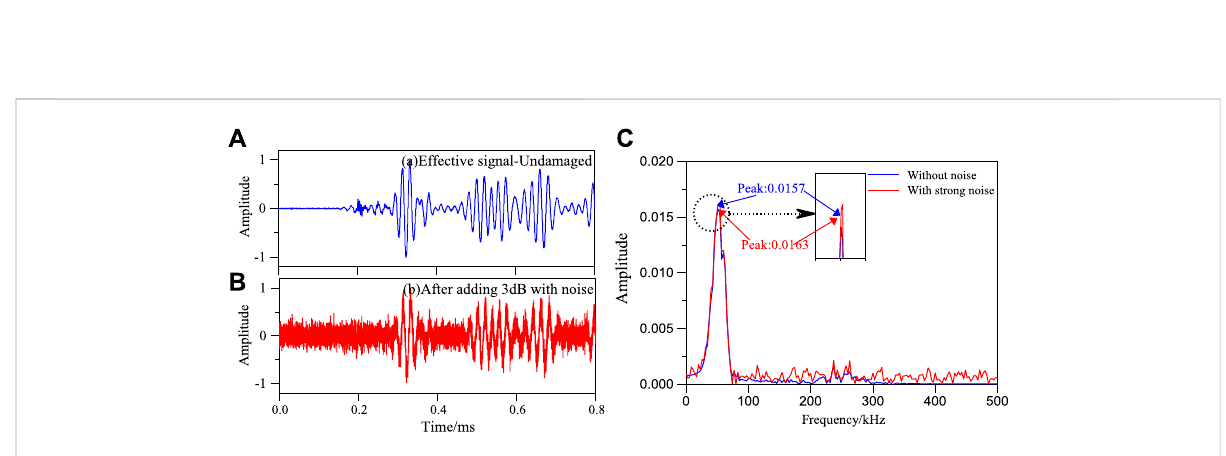
FIGURE 25 Frequency spectrum of S5 – S9 sensing channel without damage in structure under strong noise environment. (A) Effective signal-undamaged. (B) After adding 3 dB with noise. (C) Frequency spectrum of S5 – S9 signal sensing